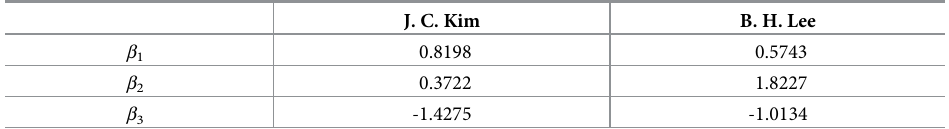
Table 3. Comparison of the estimated coefficients of two different matchups.